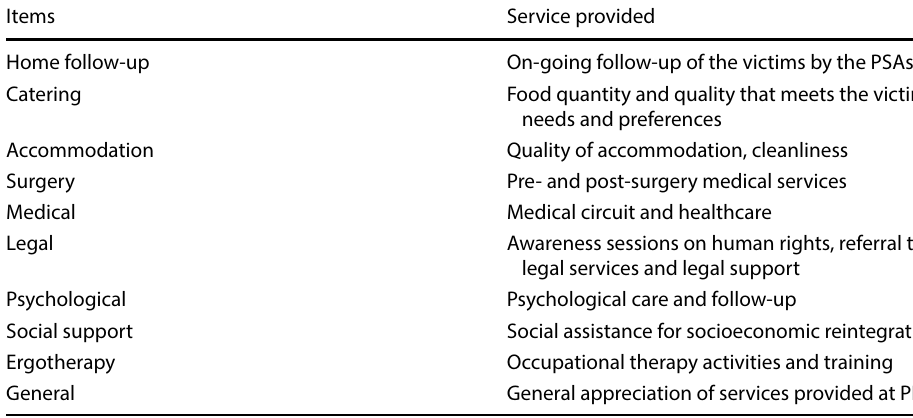
Table 1 Assessment indicators for PH service